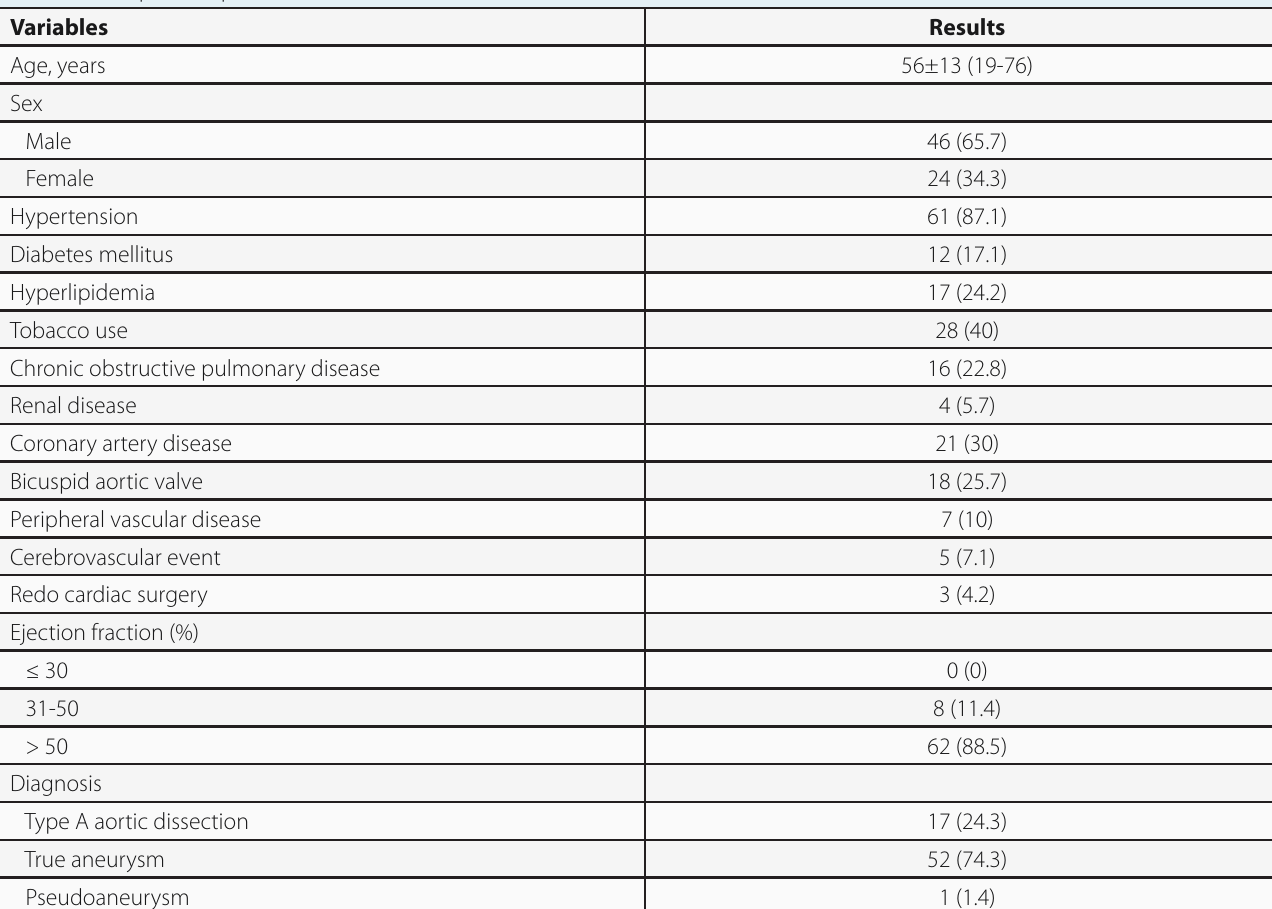
Table 1. Preoperative patients’ clinical